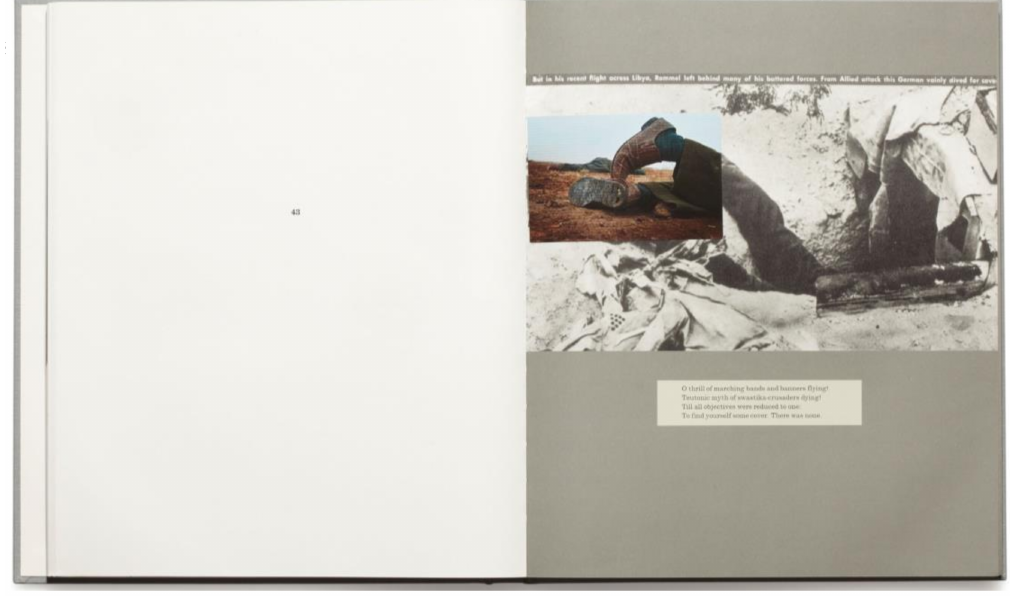
Figure 2. Plate 43. From Broomberg & Chanarin. War Primer 2 . 2011.